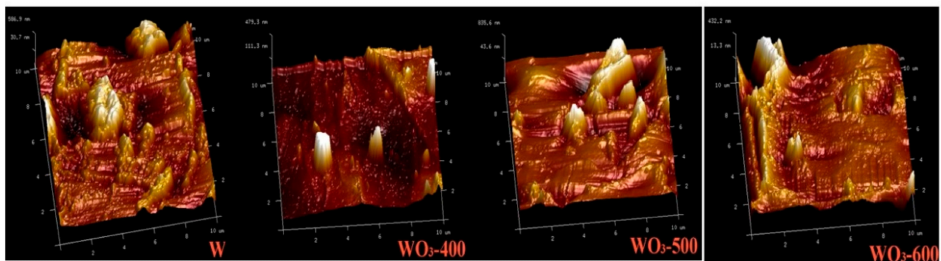
Figure 9. AFM images of W and WO 3 -X (X = 400, 500, 600).